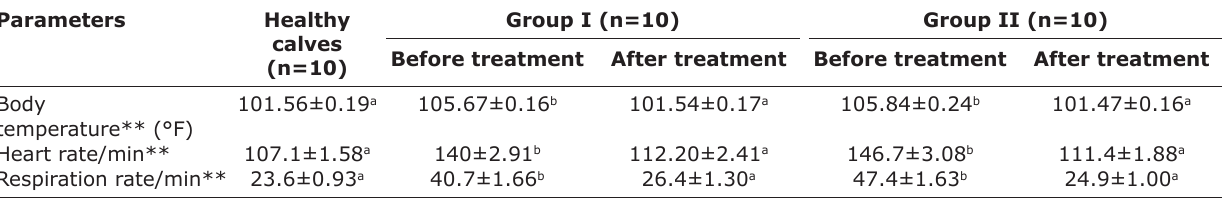
Table-1: Mean±SE value of clinical parameters in apparently healthy and bovine tropical theileriosis infected calves of Groups I and II (before and after treatment). Parameters